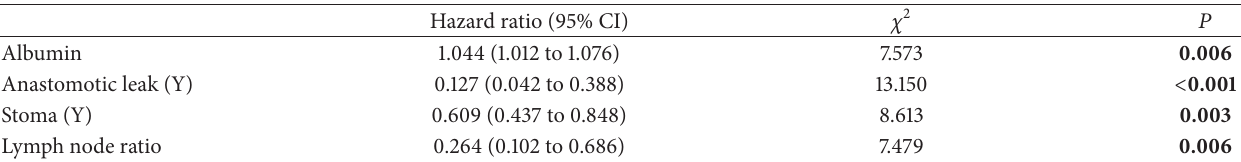
Table 4: Multivariate Cox regression analysis of hypoalbuminaemia, anastomotic leak, requirement for stoma, lymph node ratio, and association with duration of postoperative admission (for inclusion in online publication